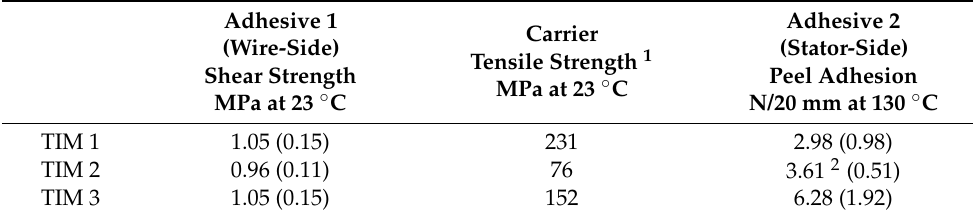
Table 2. Investigated adhesive strength of adhesive layers of TIMs (n = 5) and mechanical properties of Kapton ® -film carriers; standard deviation σ is given in